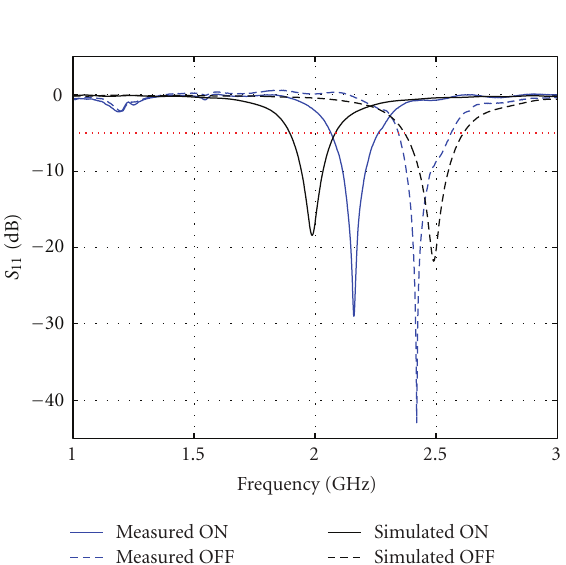
Figure 4: SPST circuit using a PIN diode.